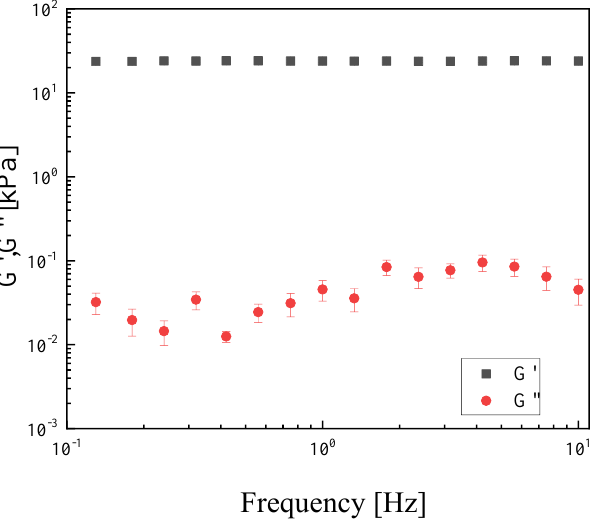
Figure 1. Storage (G´) and loss (G´´) moduli of PCB/PSB IPN hydrogel dependence on frequency.